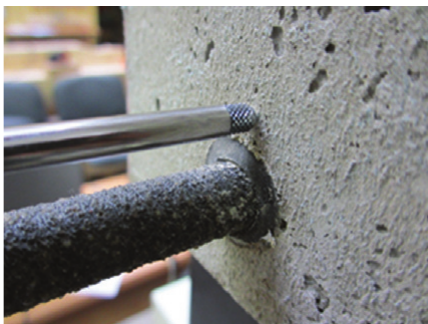
Fig. 3. Slip measurement of BFRP bar at the end of the tested